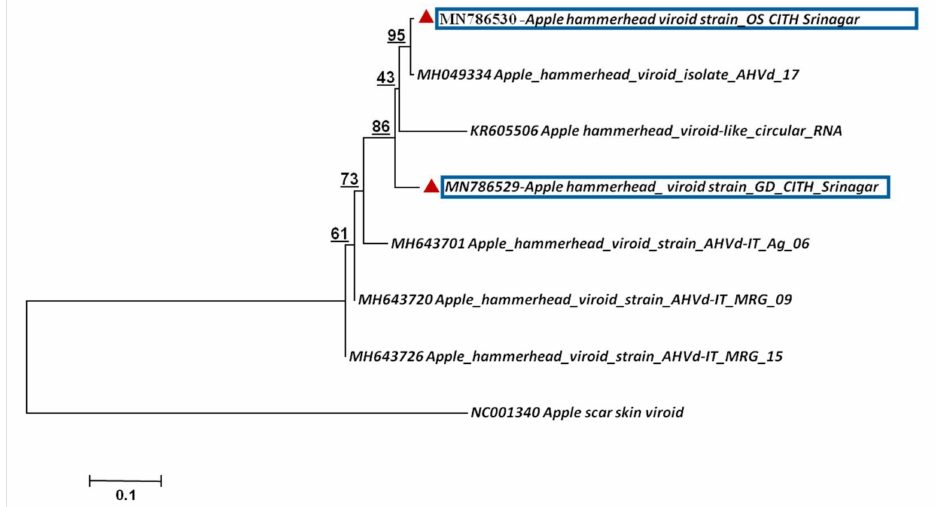
Figure 9. Phylogenetic relationship of apple hammerhead viroid based on whole-genome se- quence alignment through NJM at 1000 replications for each bootstrap value using MEGA 7.0; our AHVd isolates are highlighted with color in phylogeny. The apple scar skin viroid (ASSVd) represents